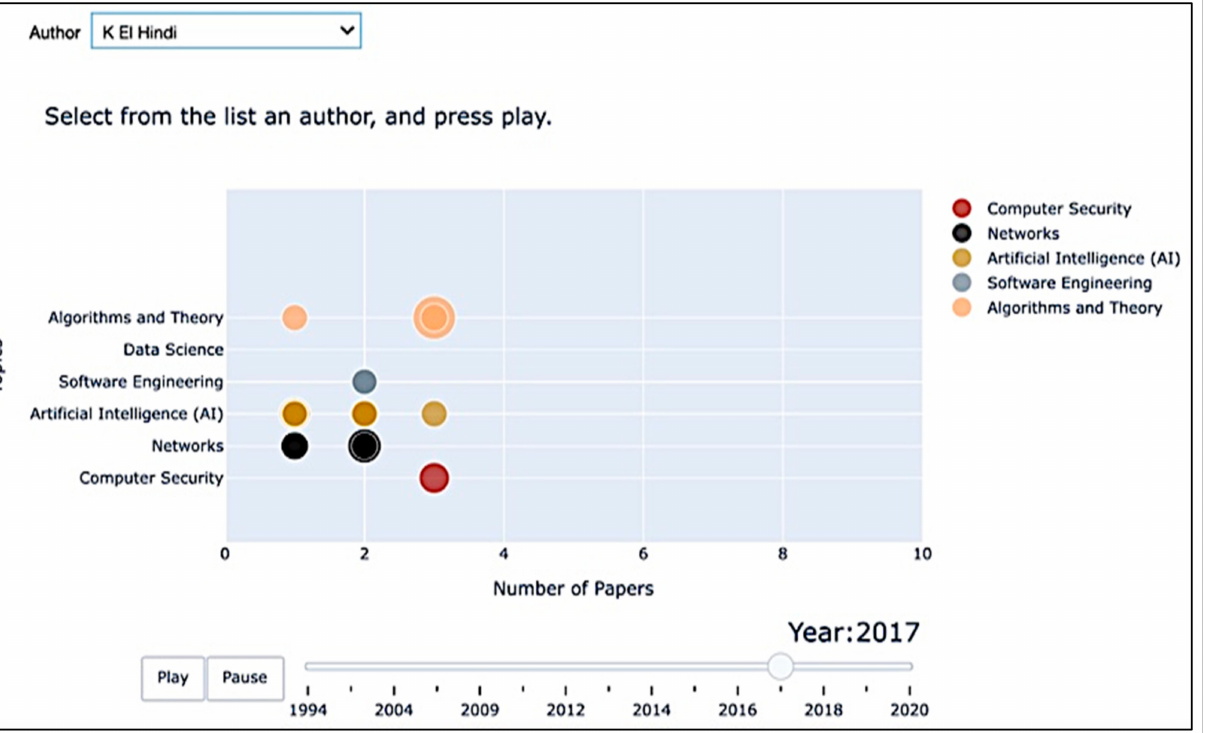
Figure 17. An animated representation of the topics’ distribution.